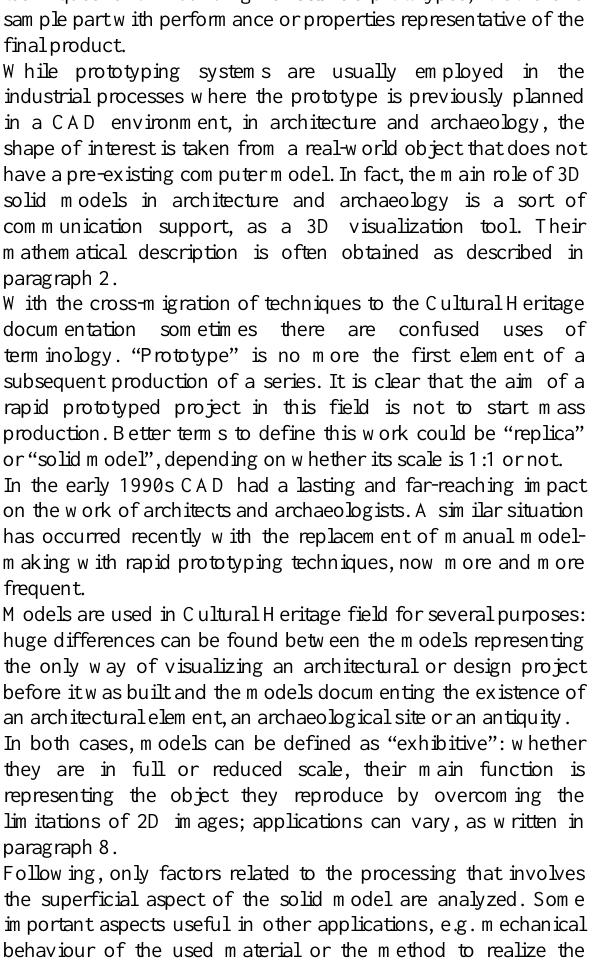
Figure 3. Schematic of the laser sintering